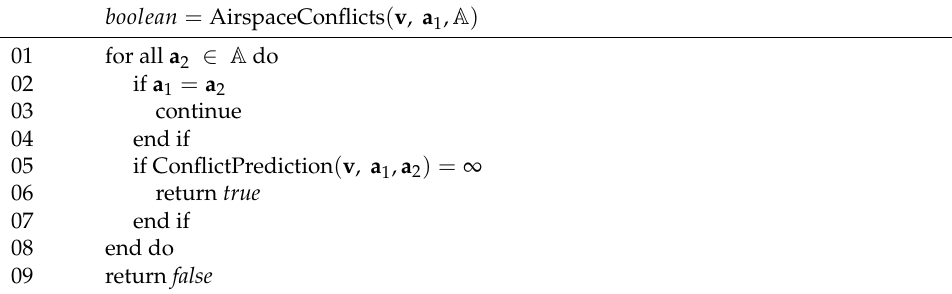
Table 3. Conflict prediction between a UAV and the